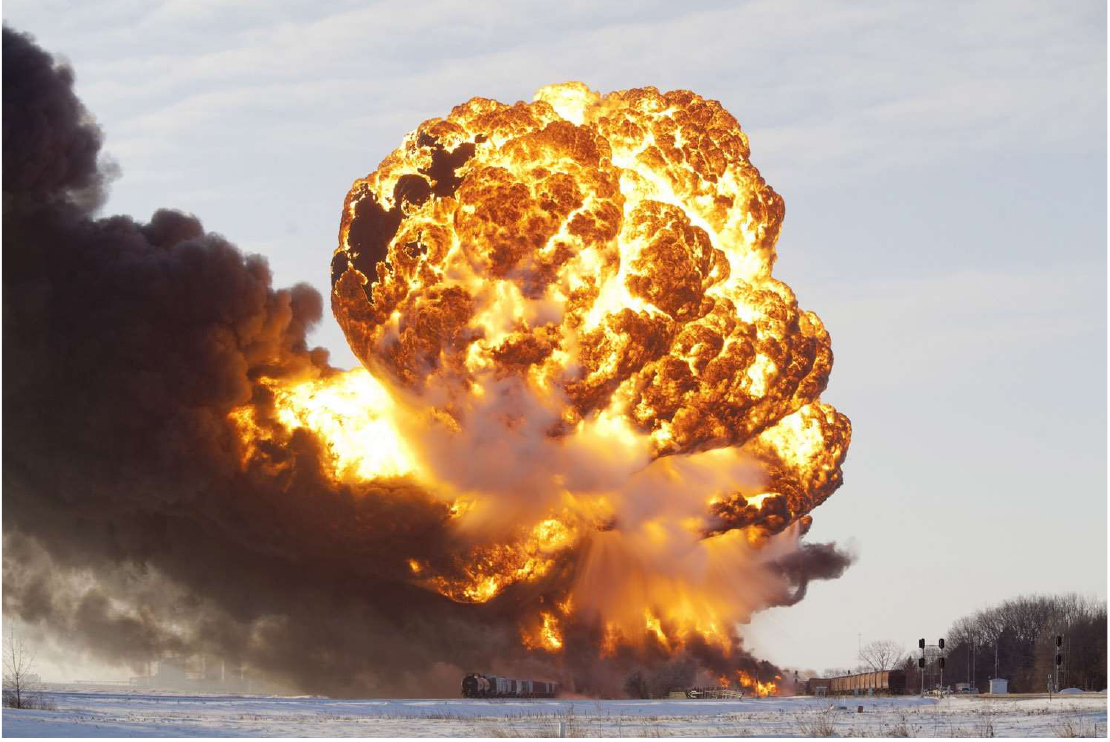
Figure 1. BLEVE accident caused after train derailment in Casselton, North Dakota (2013) [6].